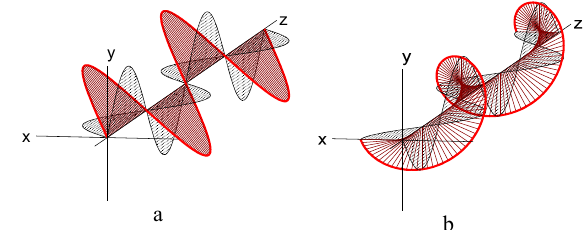
Figure 1. Light as a transversal wave with linear (a) and circular (b) polarisation.